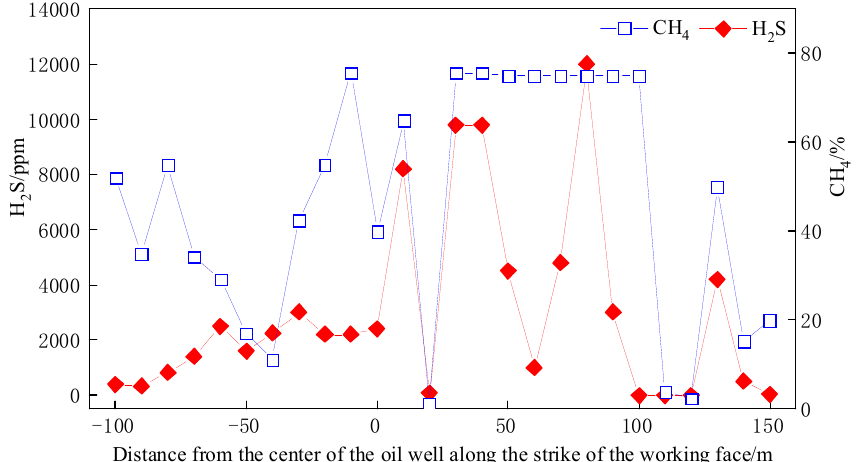
Figure 7. Distribution law of gas concentration in each borehole at the side of the transportation road in I0104 1 05 working face.